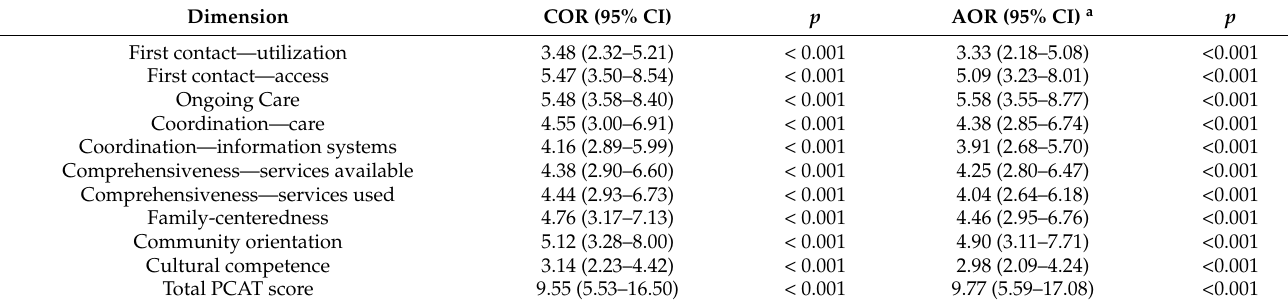
Table 3. PCAT scores associated with glycemic control